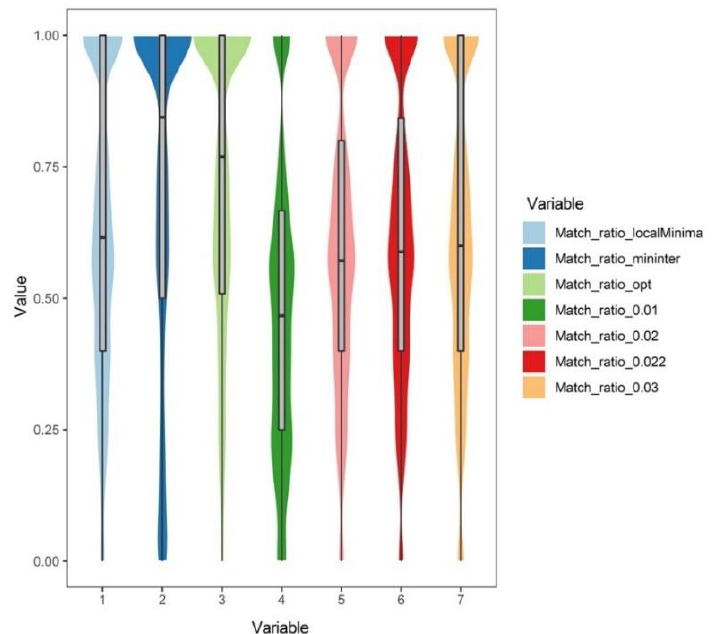
Figure 3. Match ratios of different methods. Match_ratio_*: the match ratio of 4288 genera in clustering analysis on the basis of the threshold of *. mininter: the minimum interspecific genetic distance of congeneric species; localMinima: the possible thresholds from the distance matrix; opt: the optimal thresholds.